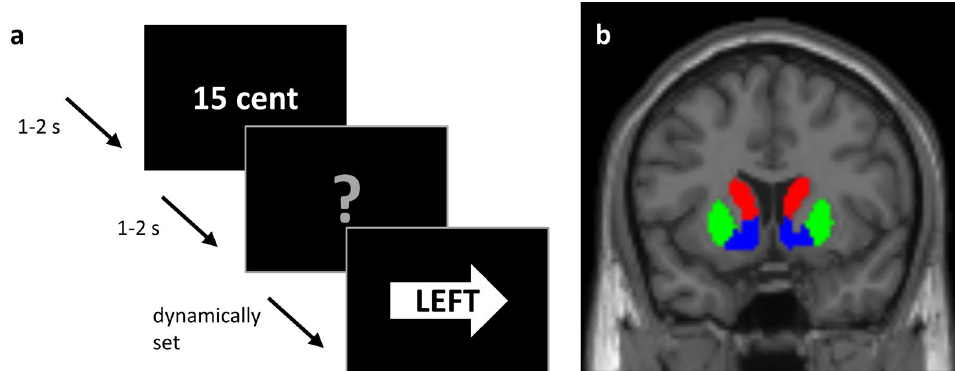
Figure 1. Schematic of data acquisition. ( a ) Schematic of an example word-arrow Stroop trial. Participants could either earn a high (15 cents) or low (1 cent) reward for a correct answer within the response window, which was cued at the start of the trial (1–2 s). After that, an information cue was presented for 1–2 s, indicating a congruent (green circle) or incongruent (red cross) trial, or giving no information about the upcoming congruency (grey question mark). Upon seeing the word-arrow Stroop target, participants had to respond to the word with a left or right button-press within the dynamically set response window. ( b ) Coronal view of our regions of interest including the bilateral caudate nucleus (red), putamen (green) and ventral striatum